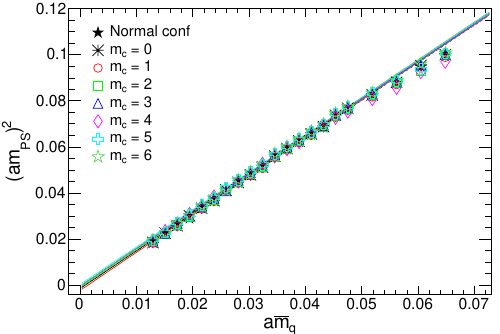
Figure 10 . The PCAC relation. The colored symbols indicate the numerical results, and the colored lines indicate the (cid:12)tting results.